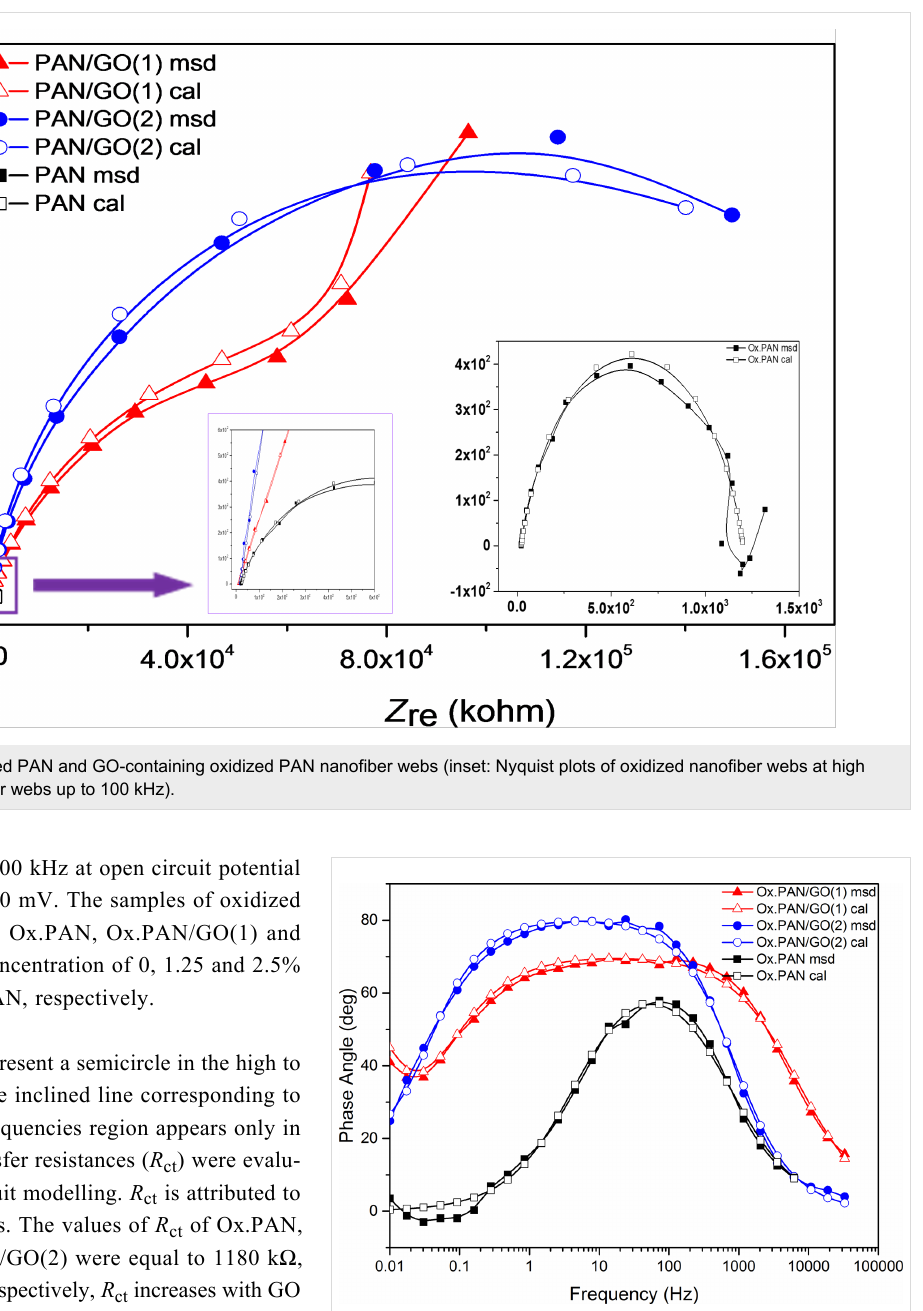
not change significantly and this is attributed to the disability of the electrolyte ions to penetrate into the electrode. The solution resistance ( R s ) of the electrochemical system changes very slightly, which can be seen in Table 1. On the other hand, the impedance of Ox.PAN/GO nanofibers is very high due to the penetration of ions into the electrode surfaces at low frequen- cies